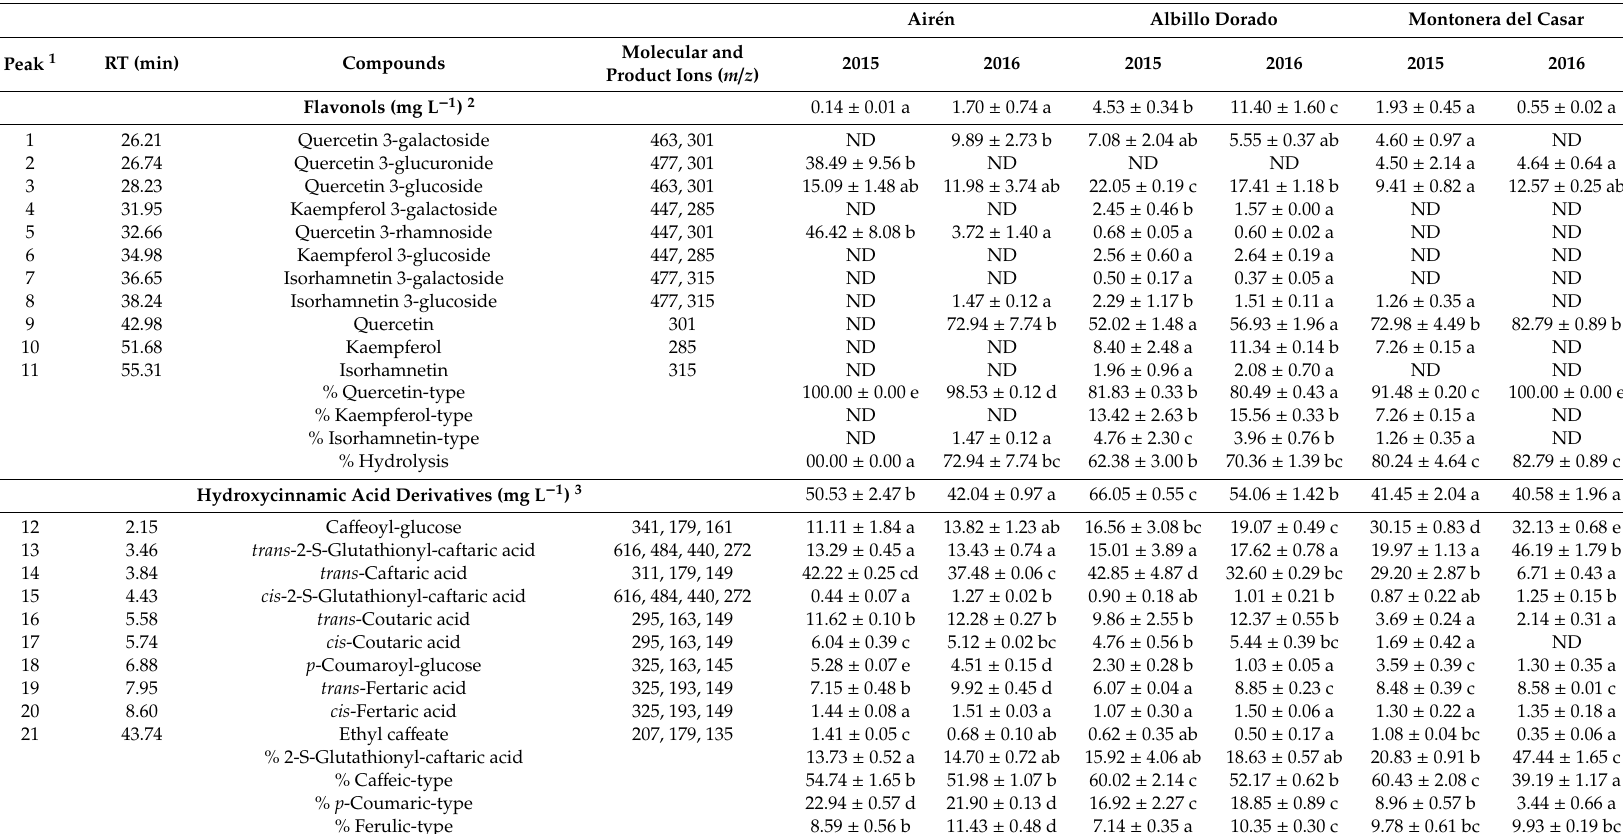
Table 1. Chromatographic and spectroscopic characteristics, molar proportions and total concentration (mean value ± standard deviation, n = 2) of the flavonols and hydroxycinnamic acid derivatives identified in white wines made from Air é n and the novel grape